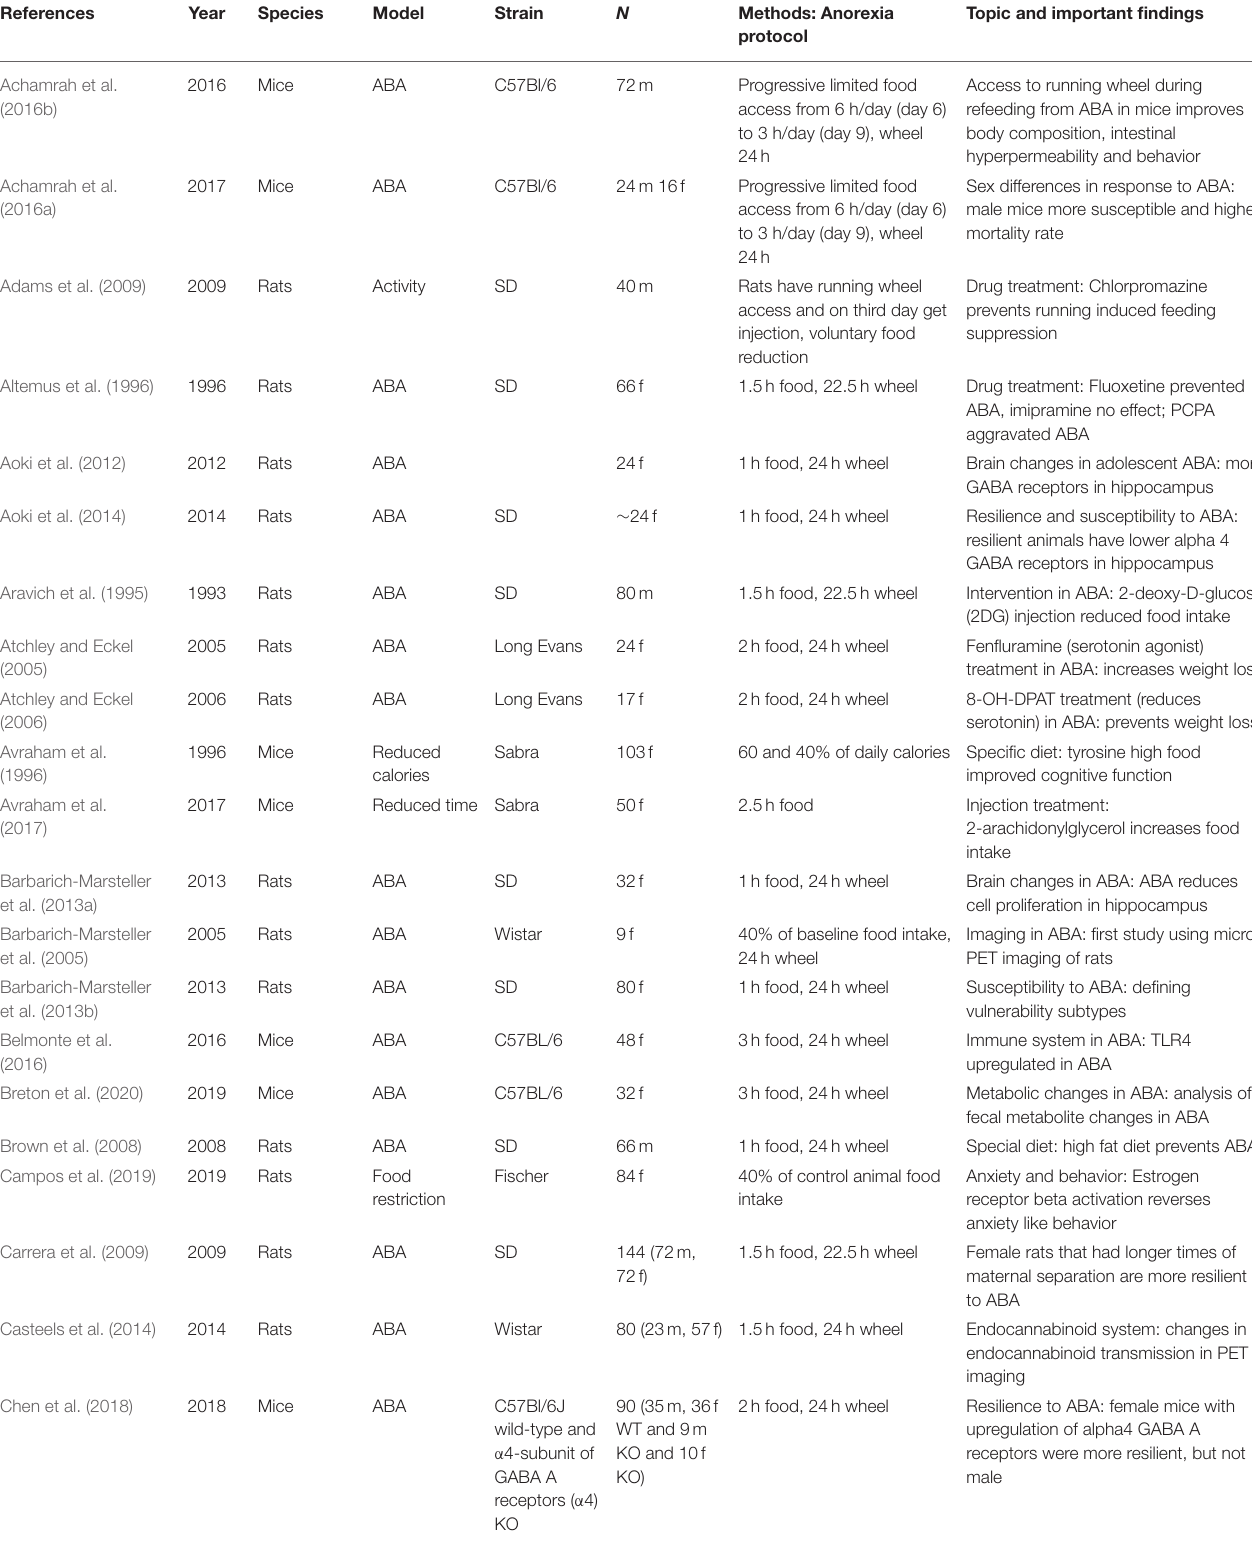
TABLE 1 | Overview of the 108 selected studies in alphabetical